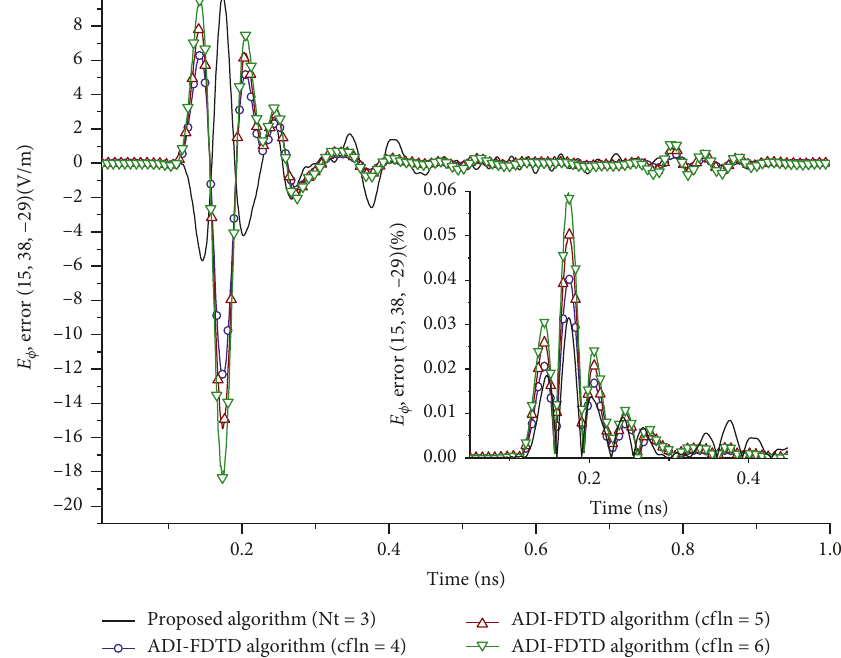
Figure 17: Errors obtained by E